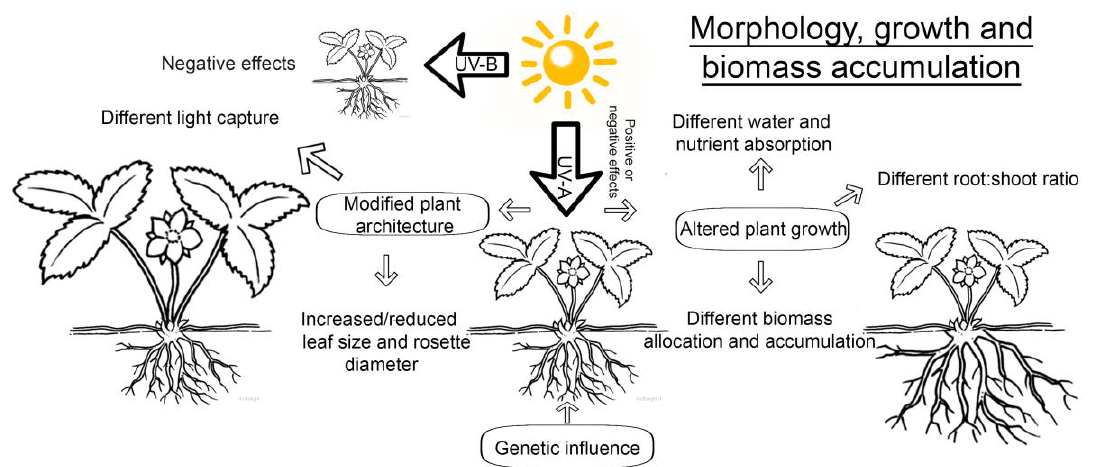
Figure 2. Plant morphological and biomass accumulation responses to UV. UV-A exposure has positive and negative effects on biomass accumulation and morphology, while UV-B effects are primarily negative. Changes in plant architecture and biomass allocation may influence resource uptake (light, water and nutrients). Changes mediated by UV-A may also depend on genetic and/or environmental factors [30].